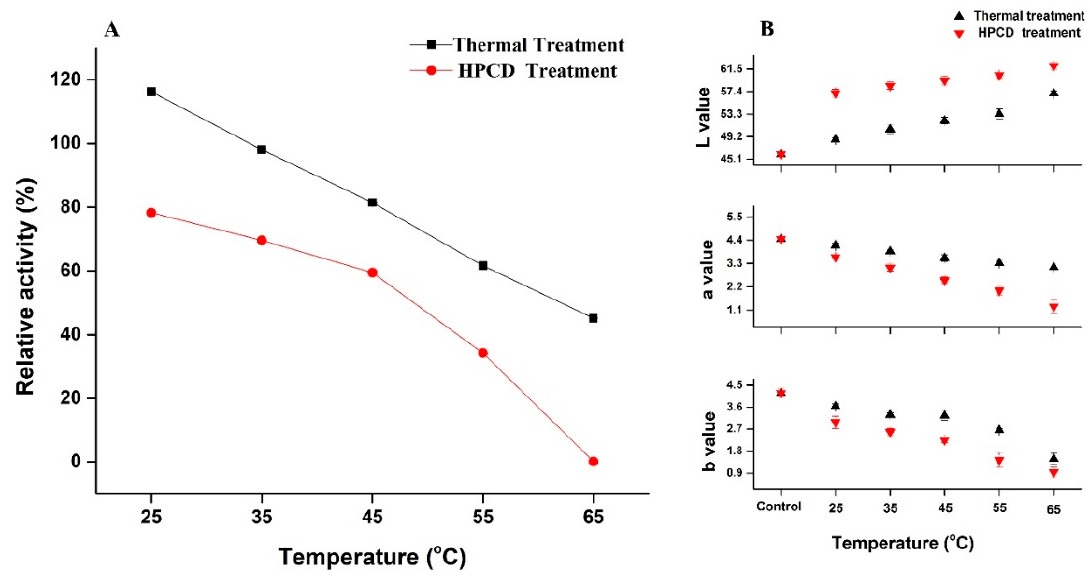
Figure 1. ( A ) Relative activity of PPO; ( B ) Color parameters (L*, a* and b*) of quince juice treated with thermal and HPCD treatment at different temperatures.